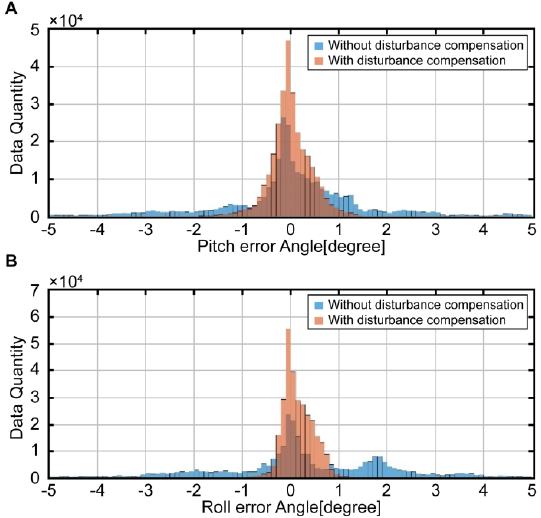
Figure 12. Histogram of attitude errors by each complementary filter; A: Pitch attitude error, B: Roll attitude error. Table 3. Attitude errors.